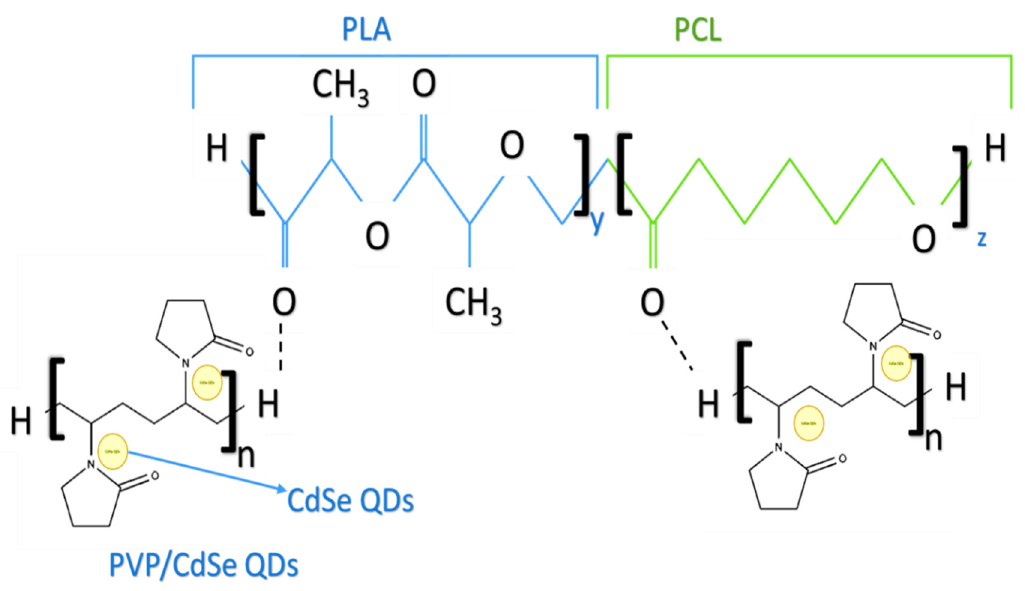
Table 3. Data after TGA analysis of pristine and functionalized nano fi bers.